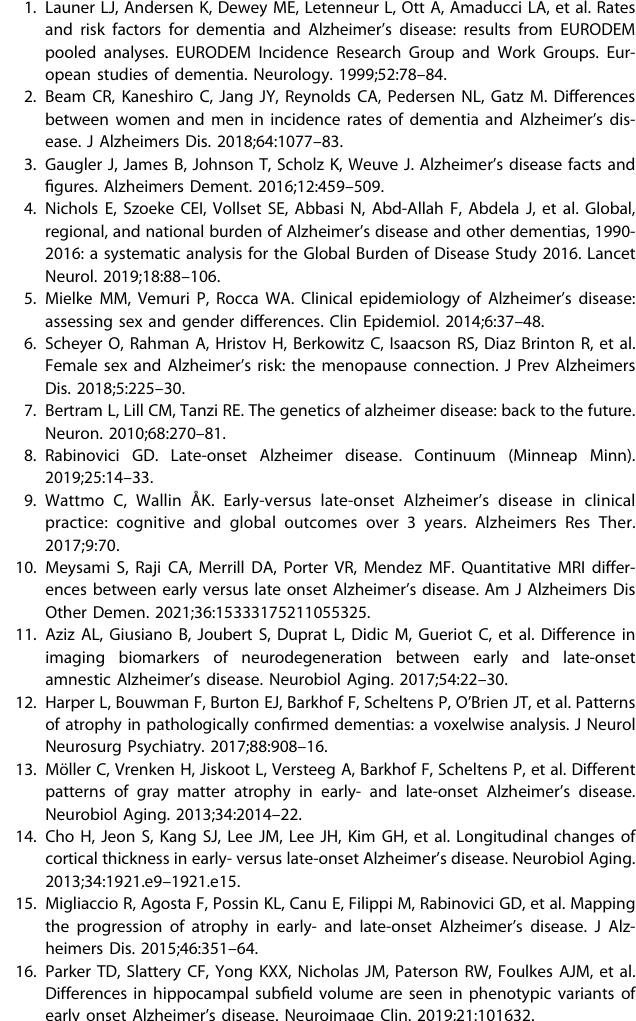
Fig. 6 Individual longitudinal performance on category fl uency (animals) test (lexical ability and executive control) and measures over estimated year from expected symptom onset (EYO) in men and women mutation carriers and non-carriers. A , B Spaghetti plot of observed category fl uency (Animals) test scores as a function of estimated year from expected symptom onset (EYO) from women (red) and men (cyan) mutation carriers and non-carriers, respec- tively. (Mutation carriers, men vs women, CDR > 0, ß = − 1.14 (SE = 0.44), p -value = 0.01; Non-carriers, men vs women, CDR > 0, ß = − 0.40 (SE = 0.59), p -value = 0.50). The longitudinal data is estimated using the rate of change from the linear mixed effects models over the years (Supplementary Table.